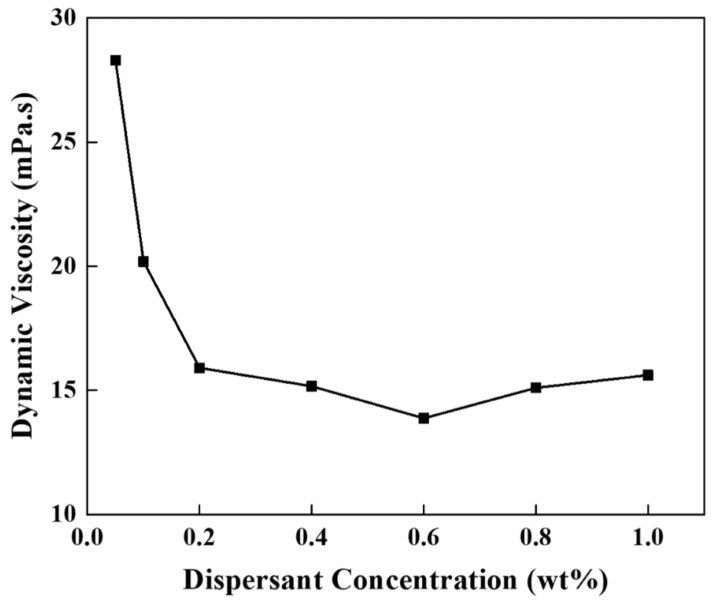
Figure 2. Effect of increasing dispersant concentration on the viscosity of Al 2 O 3 suspension for microfiltration